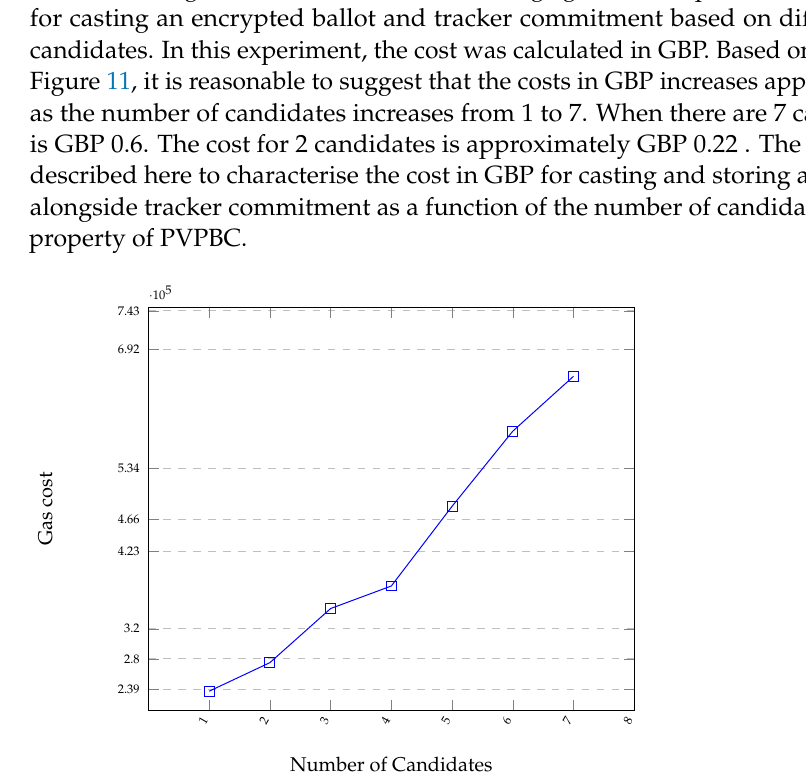
Figure 10. Gas cost for casting and storing an encrypted ballot alongside tracker commitment.